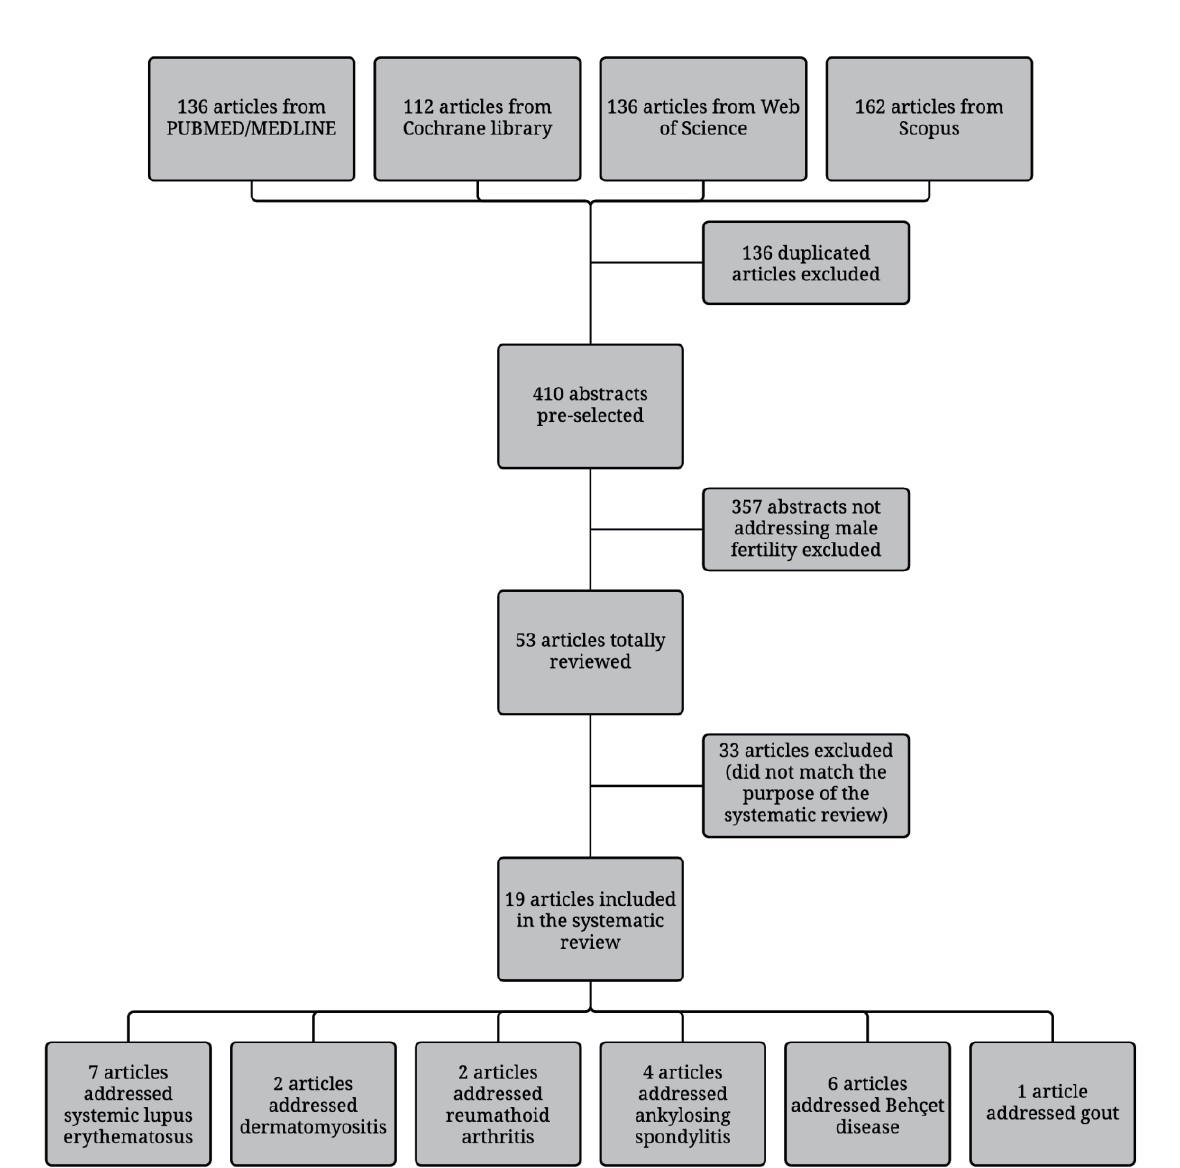
Figure 1 - Flow of articles through different phases of the systematic